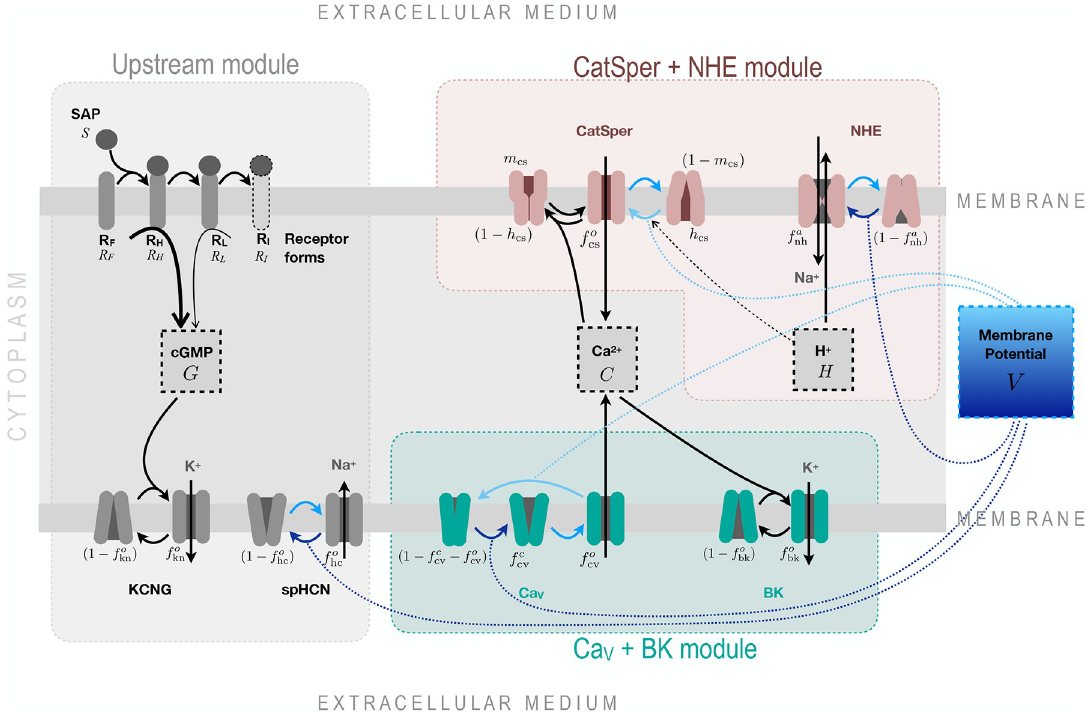
Fig 1. The modular organisation of the signalling network transducing SAP signals to Ca 2+ -spike trains. The structure is separated into 3 modules coupled by the membrane potential variable ( V ). In the Upstream module (described by the variables S , R , f c and f o ) free receptors R F bind SAP molecules and transit irreversibly through three receptor forms, each with less guanylate f o kn hc hc cyclase activity: High R H , low R L and inactive R I ; the cGMP synthesised by these receptors binds and opens KCNG channels, which conduct a hyperpolarising potassium current. The membrane hyperpolarisation promotes the opening of spHCN channels, which exert the opposite action on V when conducting a cationic inward current. Two candidate modules are presented to explain the calcium spike trains: one that includes classic voltage-dependent Ca 2+ channels and BK channels (described by variables f c that considers CatSper, NHE exchanger and proton concentration (described by f o that the calcium channel is purely voltage dependent, whereas CatSper in the other module has threefold regulation, namely Ca 2+ , H + and V . The complexity of the CatSper channel is illustrated with two gates. Voltage-regulated channel transitions are depicted with blue arrows, where the darker or lighter tones indicate whether the transition is promoted by membrane hyperpolarisation or depolarisation respectively. The blue dotted lines linking some of these arrows to the membrane potential box top or bottom provide the same information. The components in the middle dashed boxes, namely cGMP ( G ), Ca 2+ ( C ), proton ( H ) and membrane potential ( V ) are the main experimental observables. The ions K + and Na + are depicted in grey to indicate that the model describes only the currents while neglecting concentration changes.